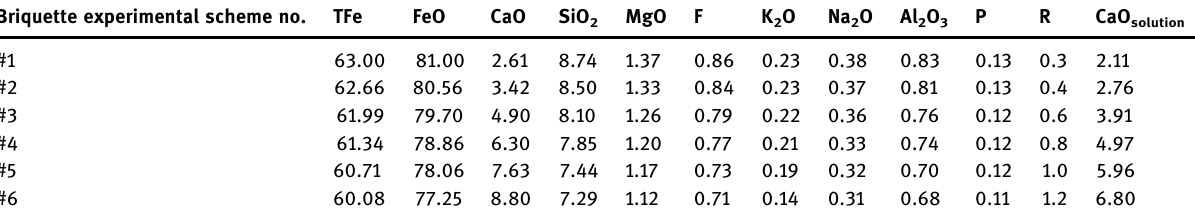
Briquette experimental scheme no.